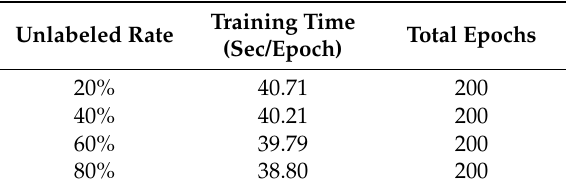
Table 8. Training time under different unlabeled